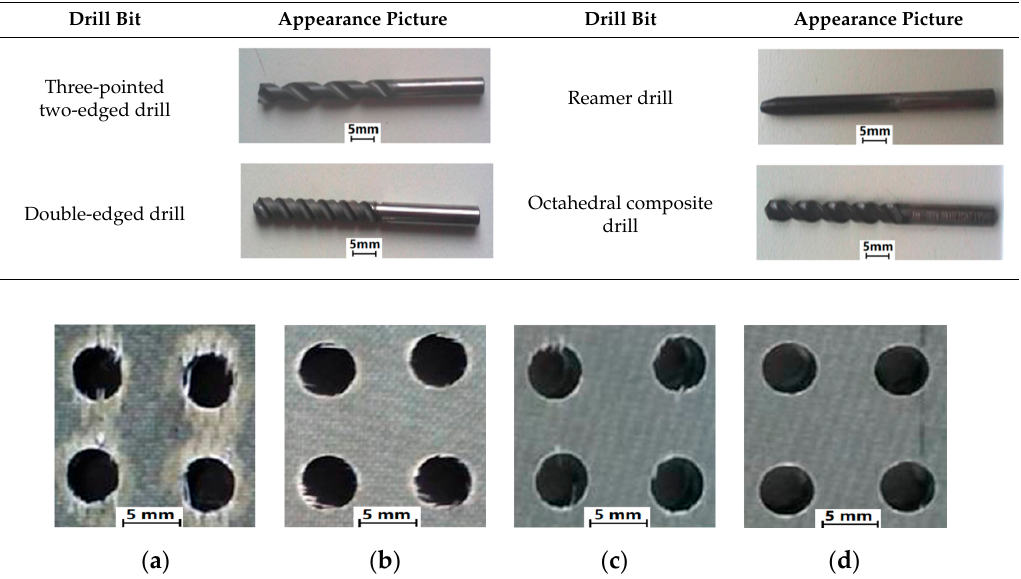
Figure 3. The appearance of the hole exit using the four types of tools: ( a ) three-pointed two-edged drill; ( b ) double-edged drill; ( c ) reamer drill; ( d ) octahedral composite drill.